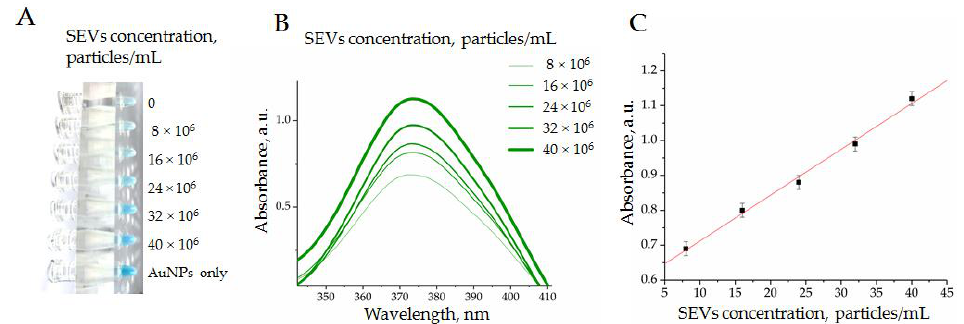
Figure 7. Enzymatic activity of AuNPs complexed by CD63 ssDNA aptamers in a range of SEV concentrations evaluated by TMB peroxidation: ( A ) the photography of tubes; ( B ) absorbance measured in experimental probes at 370 nm; ( C ) dependency of absorbance from SEV concentration in a range from 5 × 10 6 to 40 × 10 6 particles/mL.